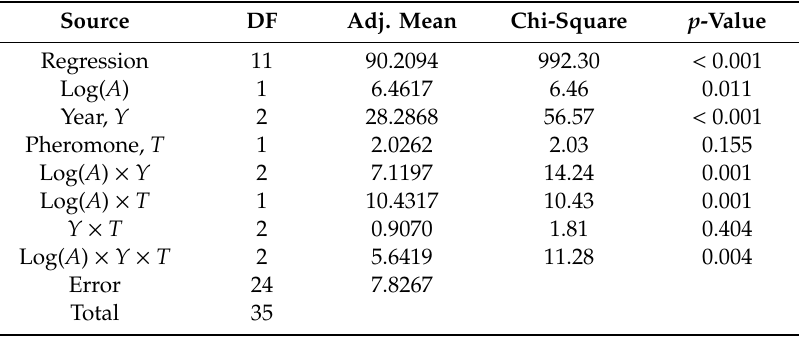
Table 2. Results of logistic regression of mating success among caged females as influenced by adult density ( A ), year ( Y ) and treatment with pheromone ( T ), Equation (2), full